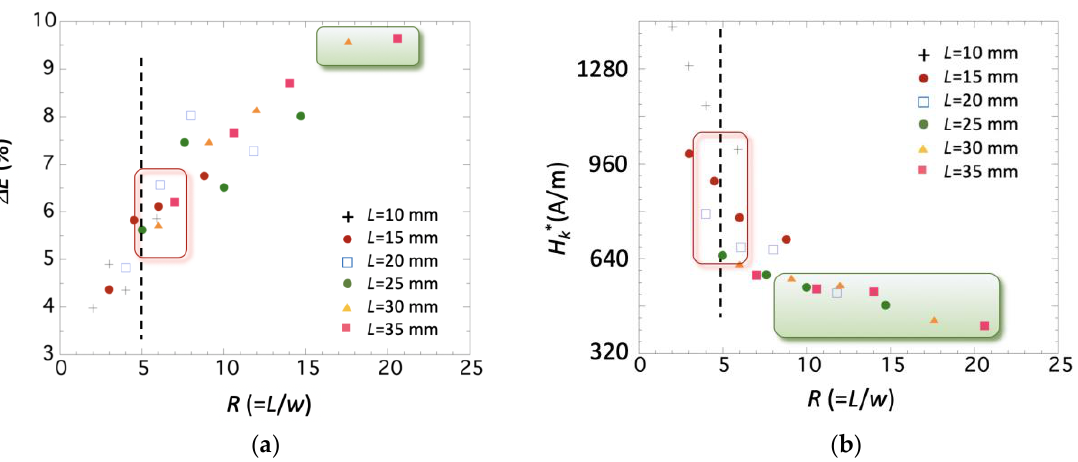
value as a function of the length-to-width ratio R , k